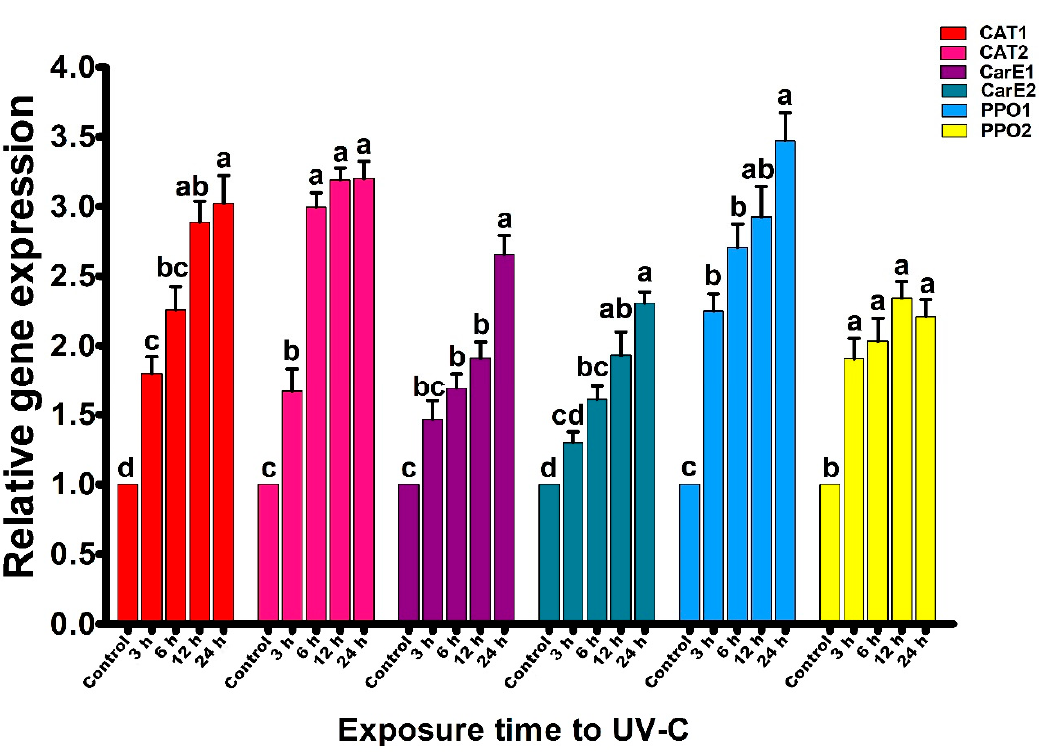
Figure 5. The gene regulation of Catalase-related (CAT1 and CAT2), Carboxylesterase-related (CarE1 and CarE2), and Prophenoloxidase-related (PPO1 and PPO2) genes of Plutella xylostella lar- vae after 0 (control), 3, 6, 12, and 24 h exposures to UV − light. The bars indicate the mean values of four replications; standard error bars indicate the standard deviation of the mean, and error bars indicate the mean deviation. Small letters indicate a significant difference among the treatments at P < 0.05, and similar letters have no significant difference among treatments.